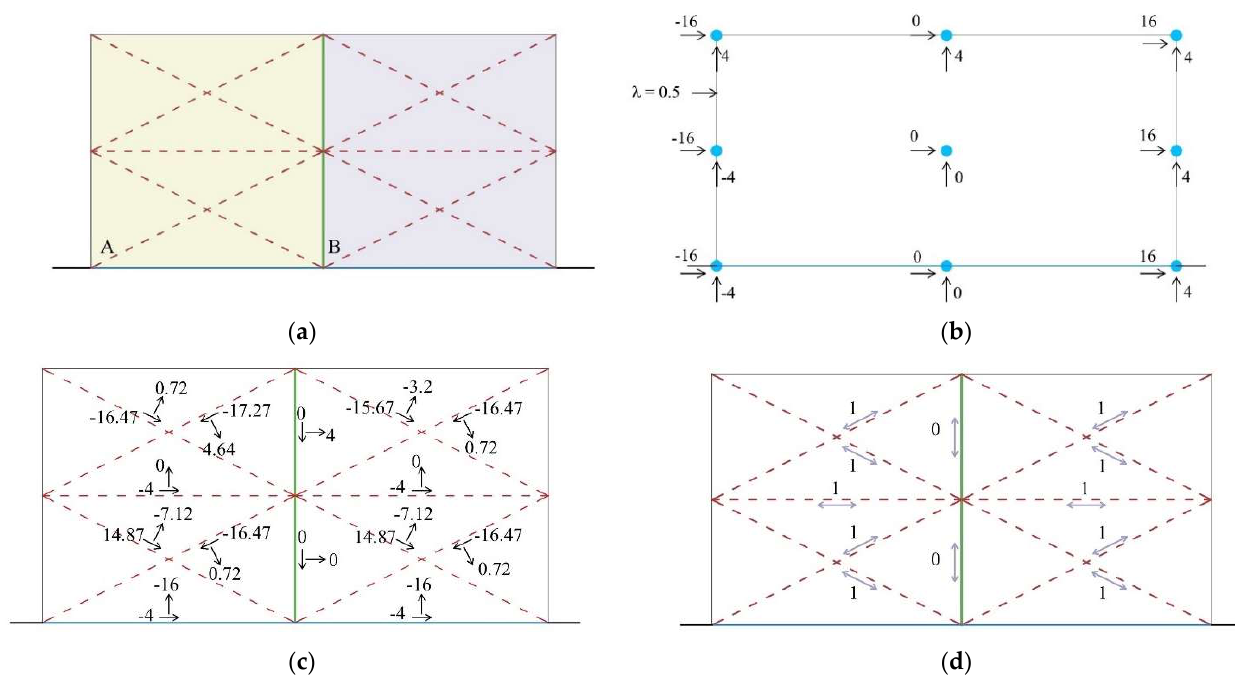
Figure 10. ( a ) The optimization result with DLO for the 2D problem generating two segments, including: ( b ) the load factor and the loads acting on the nodes; ( c ) the internal forces acting on the interfaces; ( d ) the shear strength at each interface. Capital letters A and B are used to enumerate the segments.